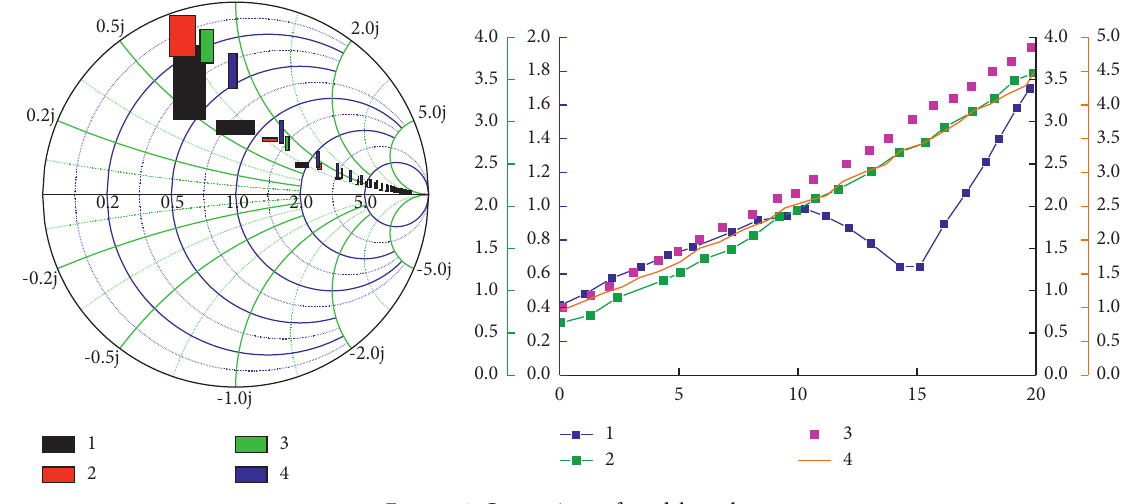
Figure 6: Comparison of model results.